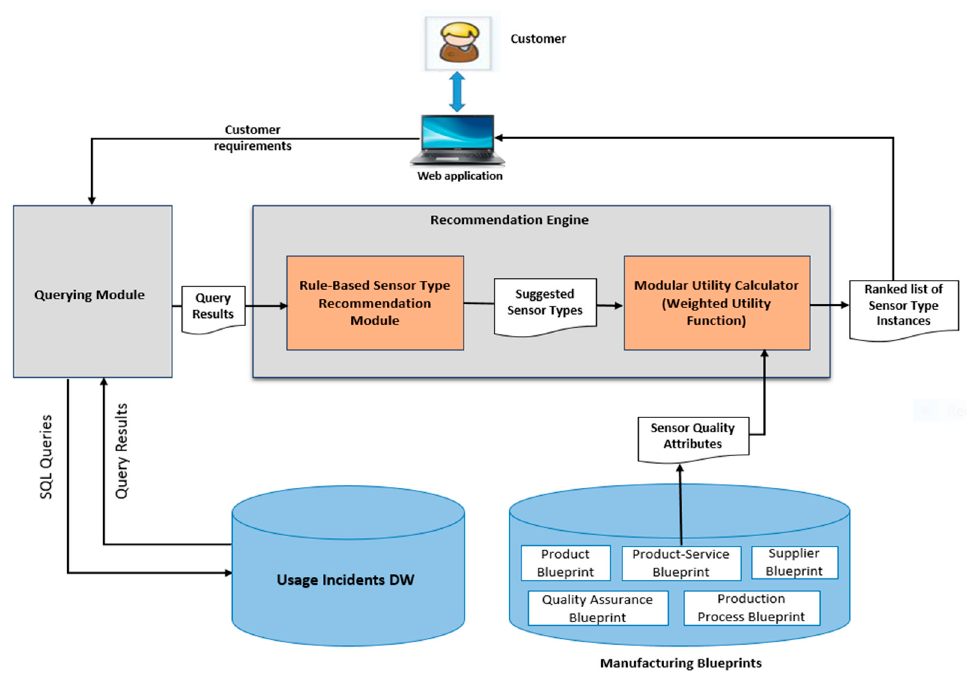
Figure 6. A high-level overview of the RS interacting components.